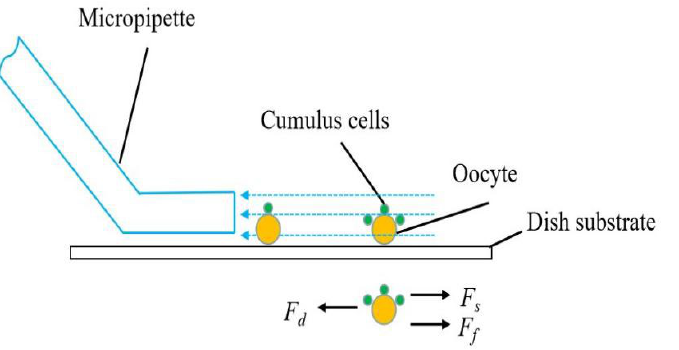
Figure 6. The schematic showing the oocyte dynamics outside the micropipette during aspiration.